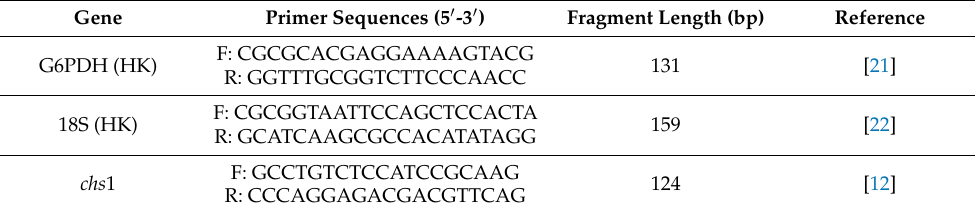
Table 1. Primers pairs used in gene expression analyses. For each gene, the forward and the reverse primers are shown. HK = housekeeping gene. Gene Primer Sequences (5 (cid:48) -3 (cid:48)